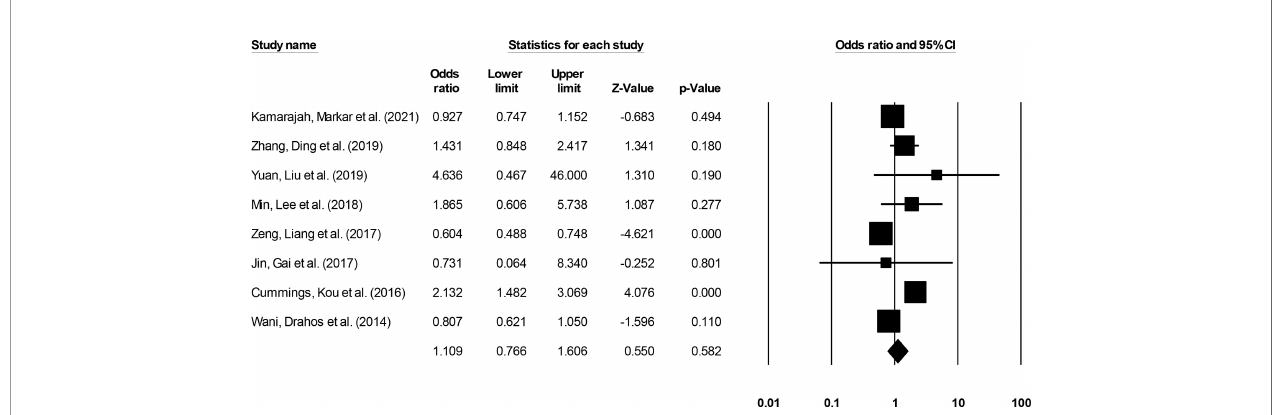
FIGURE 9 | The forest plot for studies evaluating the short-term survival outcome in patients with super fi cial esophageal squamous cancer undergoing endoscopic submucosal dissection or esophagectomy. The odds ratios are presented as black boxes whereas 95% con fi dence intervals are presented as whiskers. A higher odds ratio represents higher odds of short-term survival outcome for patients receiving endoscopic submucosal dissection, and a lower odds ratio represents higher odds of short-term survival outcome for patients receiving esophagectomy.